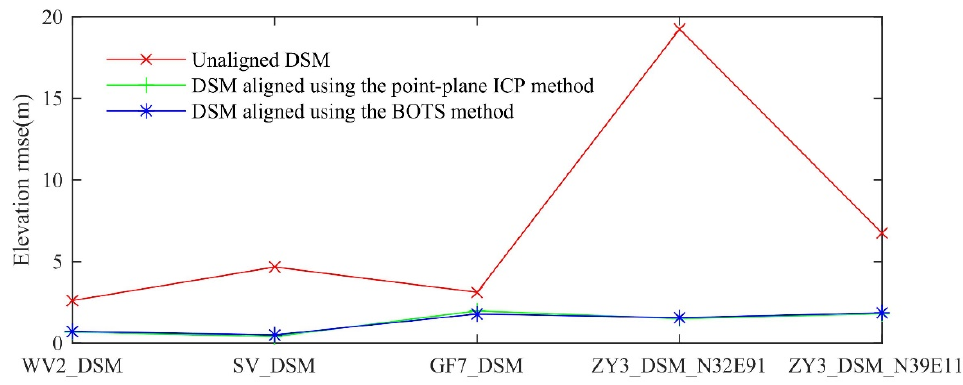
Figure 9. DSM elevation residual distribution: ( a – e ) is the absolute value of the elevation residual and the mean of the absolute value of the elevation residual at the quartile before and after the ICP and BOTS algorithms were used for registration.